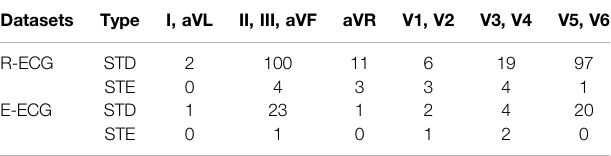
Frontiers in Physiology |